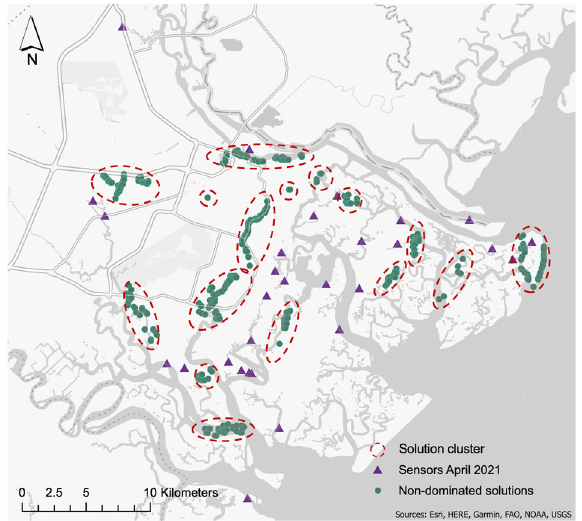
Fig. 4 Sequential expansion sensor network showing locations of new sensor installations and evolution of non-dominated solutions after including a new set of sensors. Existing sensor locations (purple triangles), prioritized Pareto set of potential new sensor locations found from running proposed multi-objective optimization model (green circles), fi ve main solution clusters identi fi ed and considered in collaboration with community decision-makers (dashed red ellipses A – E), selected new sensor locations based on decision-making process (orange and blue triangles), and new set of prioritized non-dominated solution locations with an updated network of sensors (gold